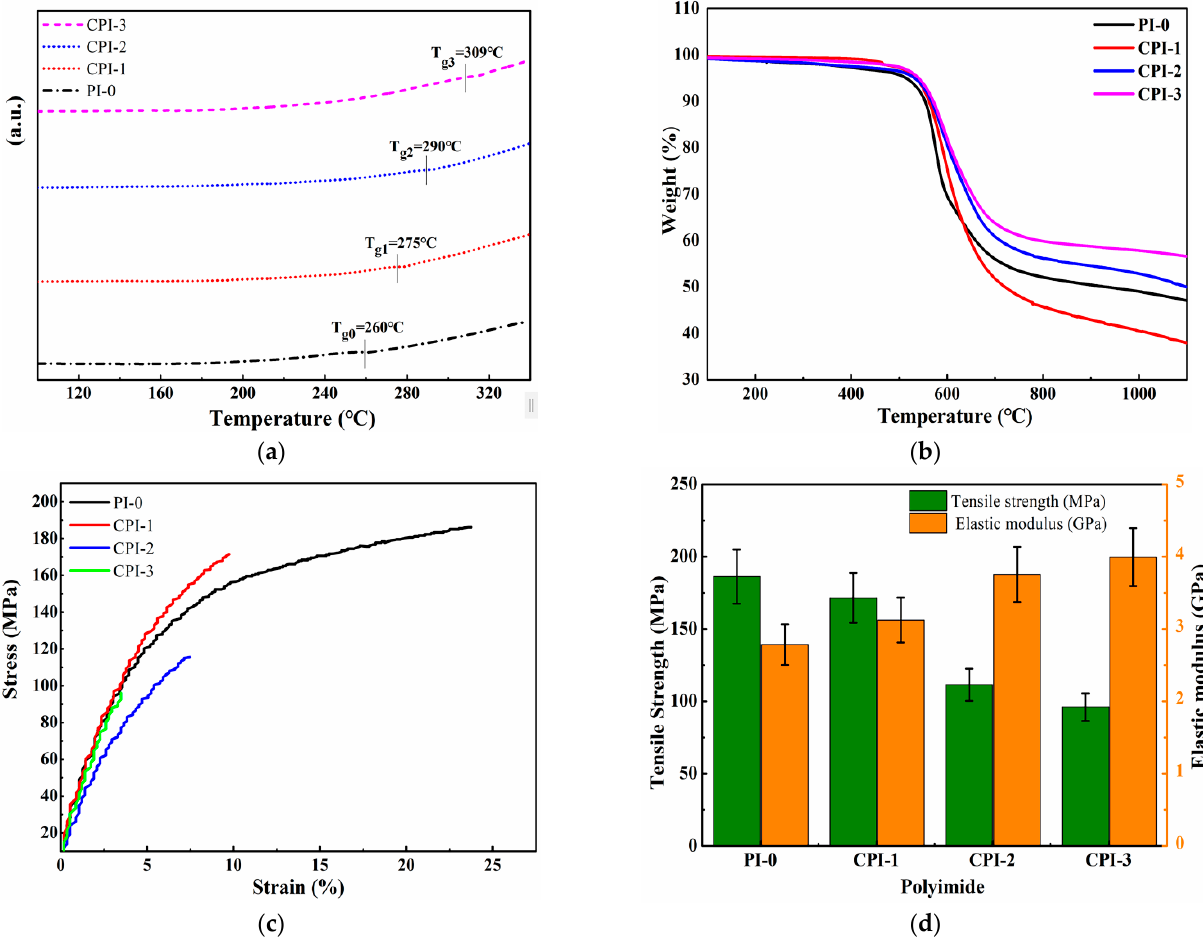
Figure 3. ( a ) DSC, ( b ) TGA, and (c ) stress–strain curve of the CPI films. ( d ) Histogram of tensile strength and elastic modulus. Table 1. Thermal and mechanical properties of the CPI films.